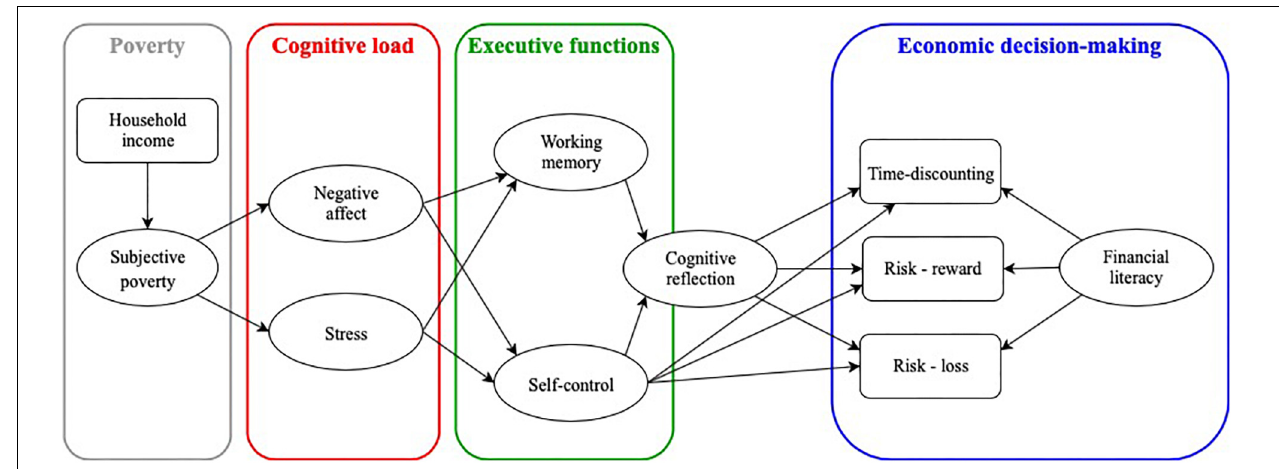
FIGURE 1 | Conceptual visualization of the hypothesized cognitive mechanism of poverty perpetuation.